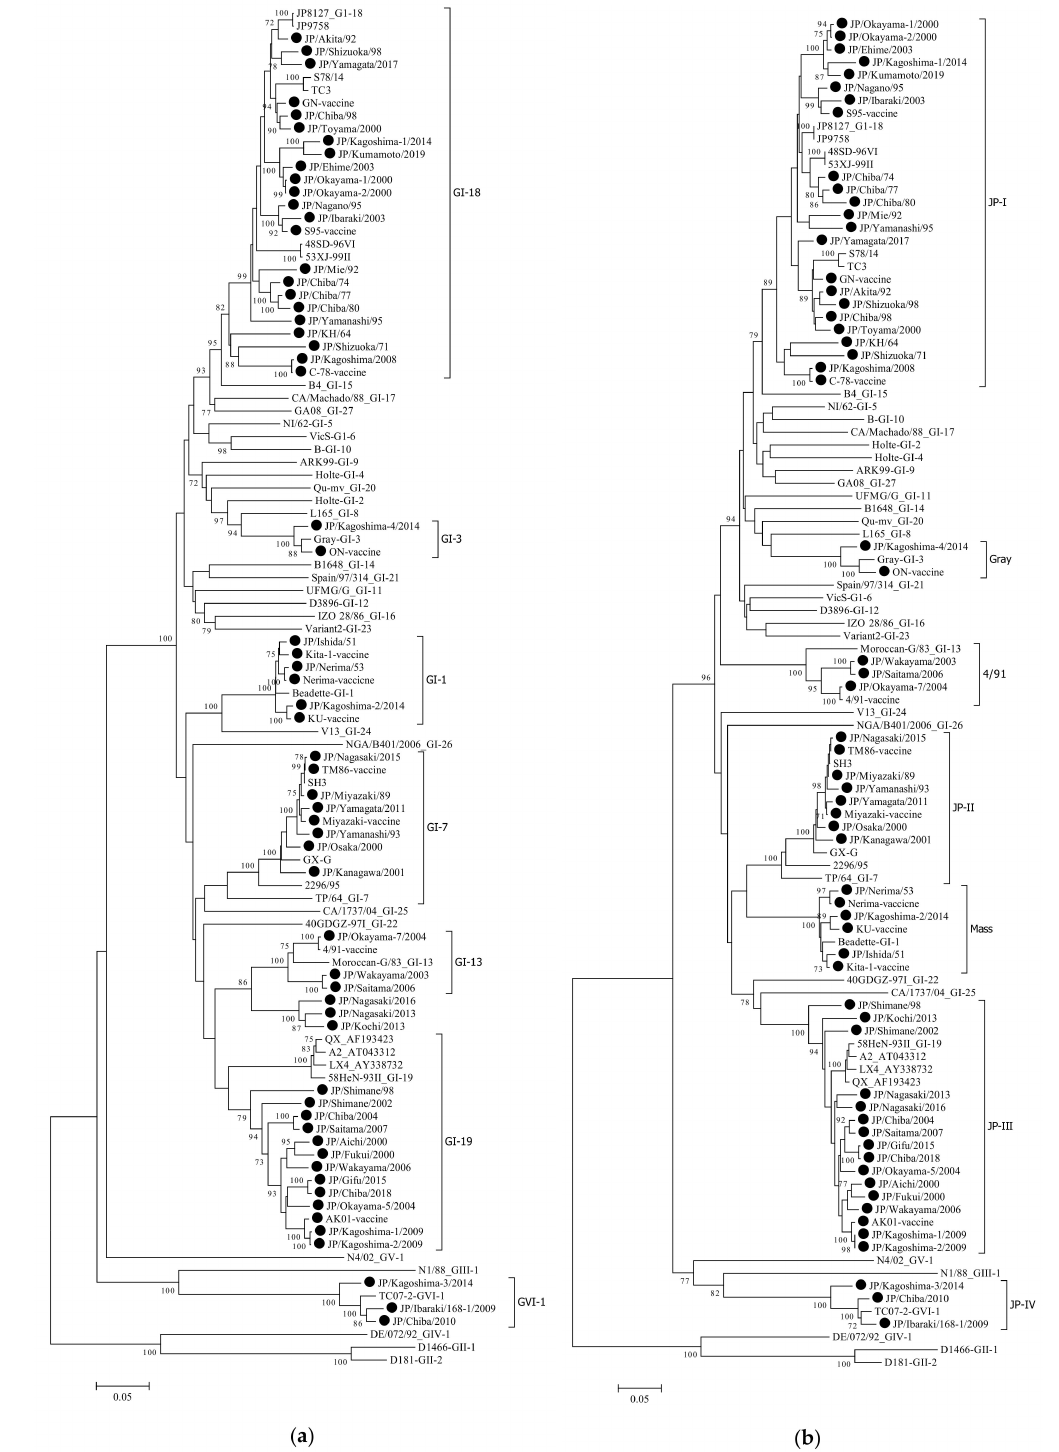
Figure 1. Phylogenetic trees that are based on the complete ( a ) and partial ( b ) S1 glycoprotein gene of the infectious bronchitis virus (IBV), strain Beaudette (GI-1, GenBank Accession No. NC001451). For ( a , b ), nucleotides 20368–21978 (1632 bases) and nucleotides 20368–20988 (621 bases), respectively, were subjected to phylogenetic analysis. Subsequently, both trees were generated using the neighbor- joining method in MEGA 7 [15] with 1000 bootstrap replications. All tools were run with the default parameters unless otherwise specified. Then, horizontal distances were proportionally set to the minimum number of nucleotide differences that were required to join nodes and sequences. The IBV genotypes were defined as described previously